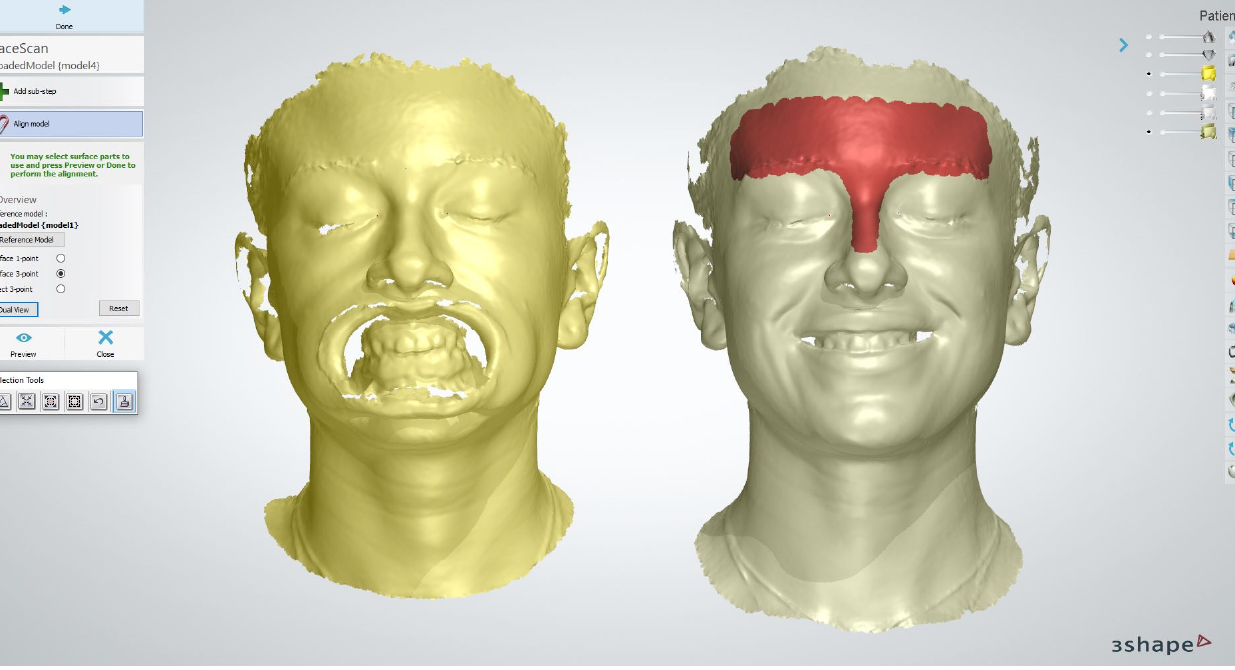
Figure 7. Matching the face scan with retractor with the face scan with smile.